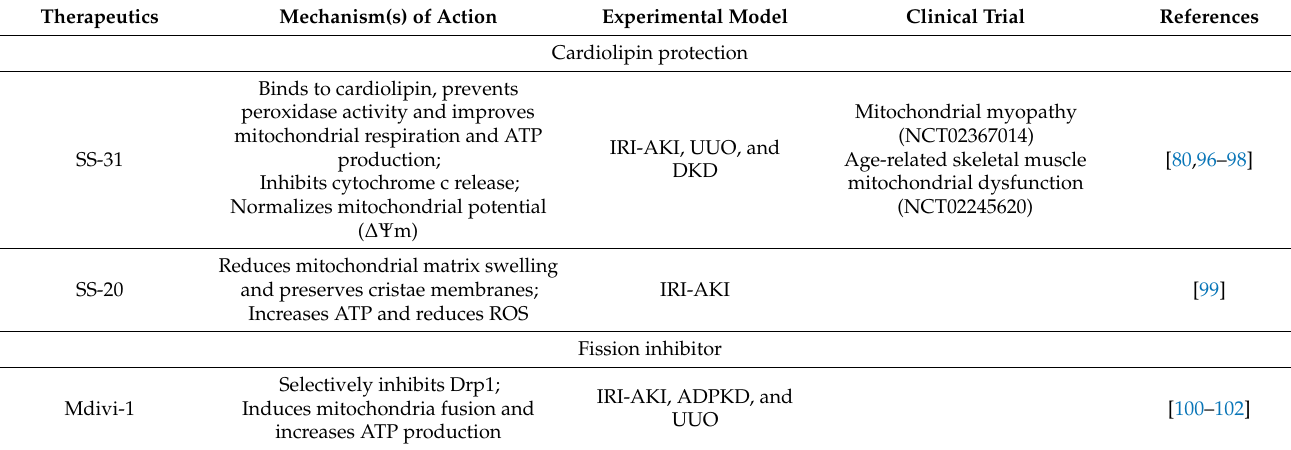
Table 1. The therapeutic compounds that target mitochondrial